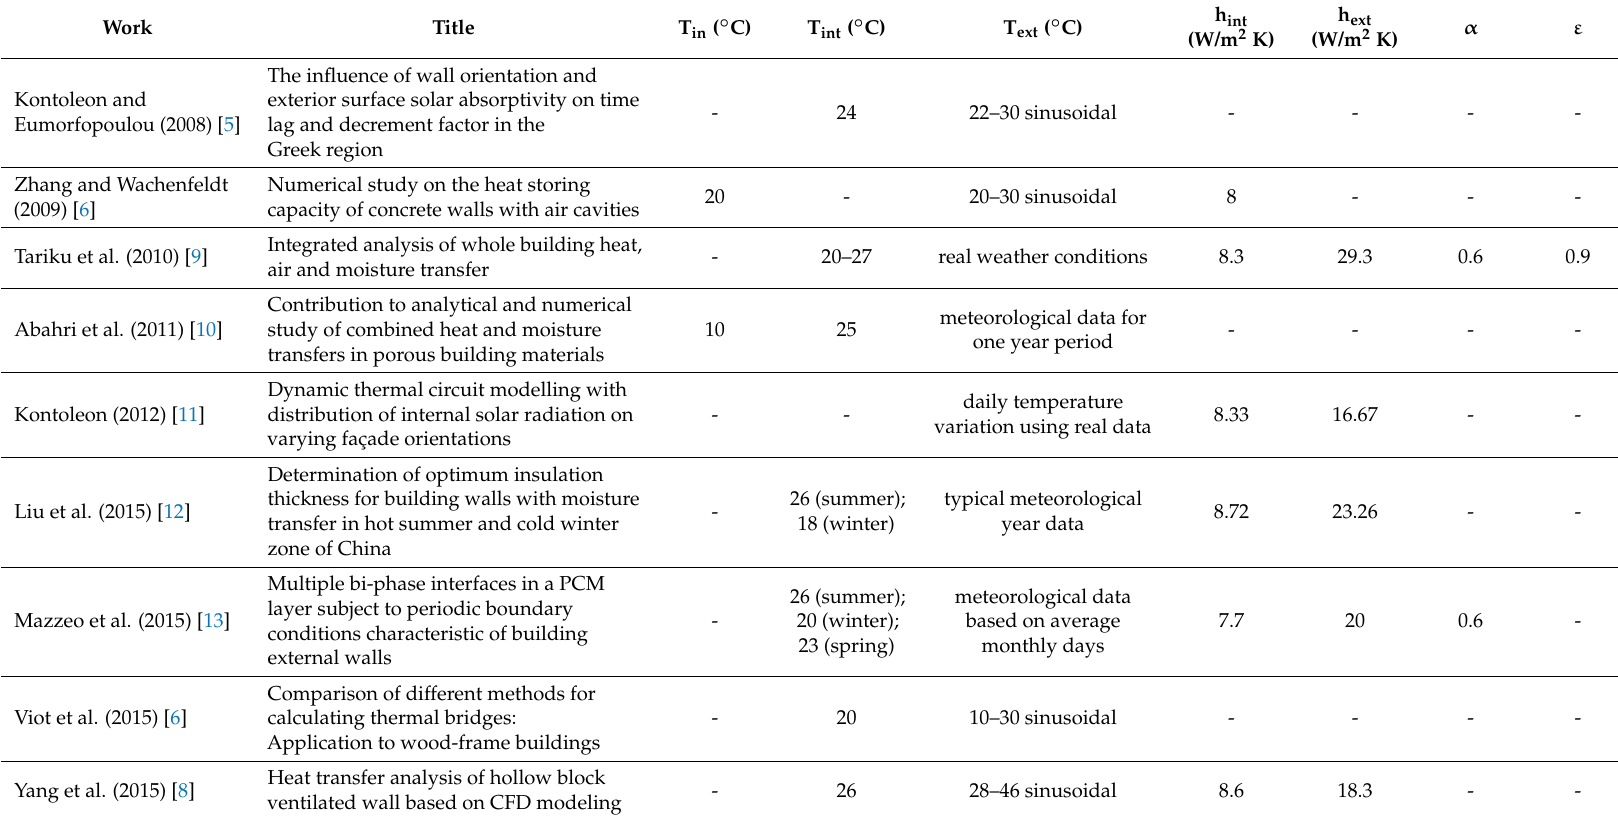
Table 1. Review table of the boundary conditions for previous numerical simulation studies of heat transfer in building